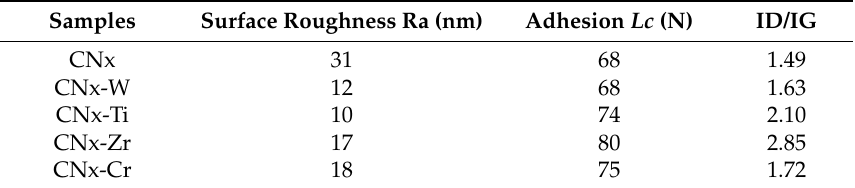
Table 2. Surface roughness, adhesion and ID/IG values (Raman analyses) of CNx and 6 at. % metal-doped CNx coatings.